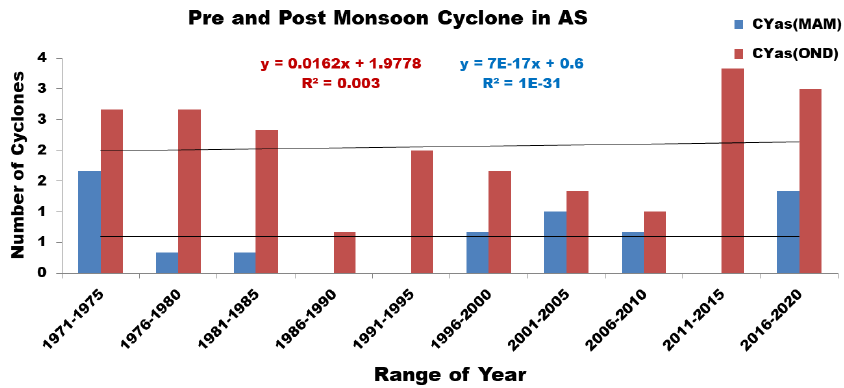
Figure 7. Comparison of pre −monsoon and post − monsoon cyclone frequencies in BOB.